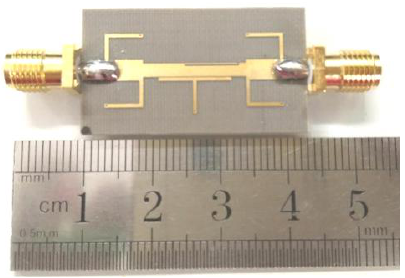
Figure 7. The photograph of the fabricated filter.